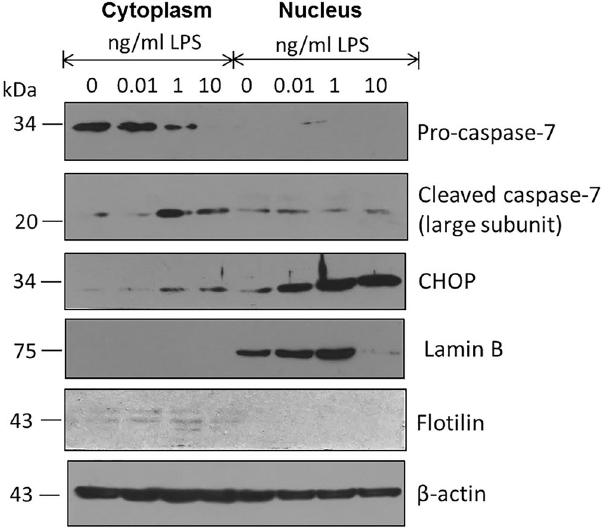
Figure 3. LPS treatment promotes cleavage activation of caspase-7 in the cytoplasmic fraction of macrophages. While the presence of pro-caspase-7 in the cytoplasmic fraction decreases with high LPS concentrations in the culture media of macrophages, the presence of caspase-7 increases in parallel with an important increase of CHOP in the nuclear fraction. Lamin-B used as a control associated to the nuclear fraction, flotilin for the cytoplasmic one and β -actin as the general loading